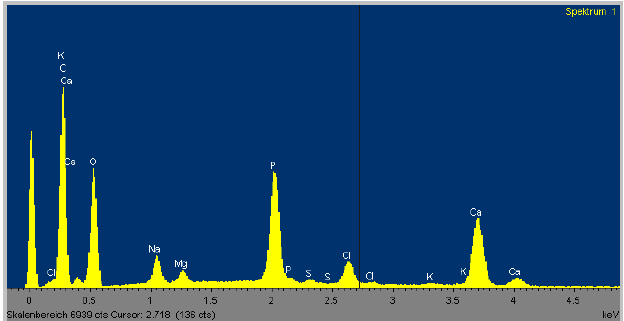
Figure 6. Energy dispersive X-ray microanalysis (EDX) spectrum of an exemplary dish from the osteogenic group showing the distinct presence of calcium and phosphorus. The various calcium peaks are caused by the proof of calcium at different energy levels. The high carbon peak is due to the carbon sputtering as demanded for proper EDX scanning.